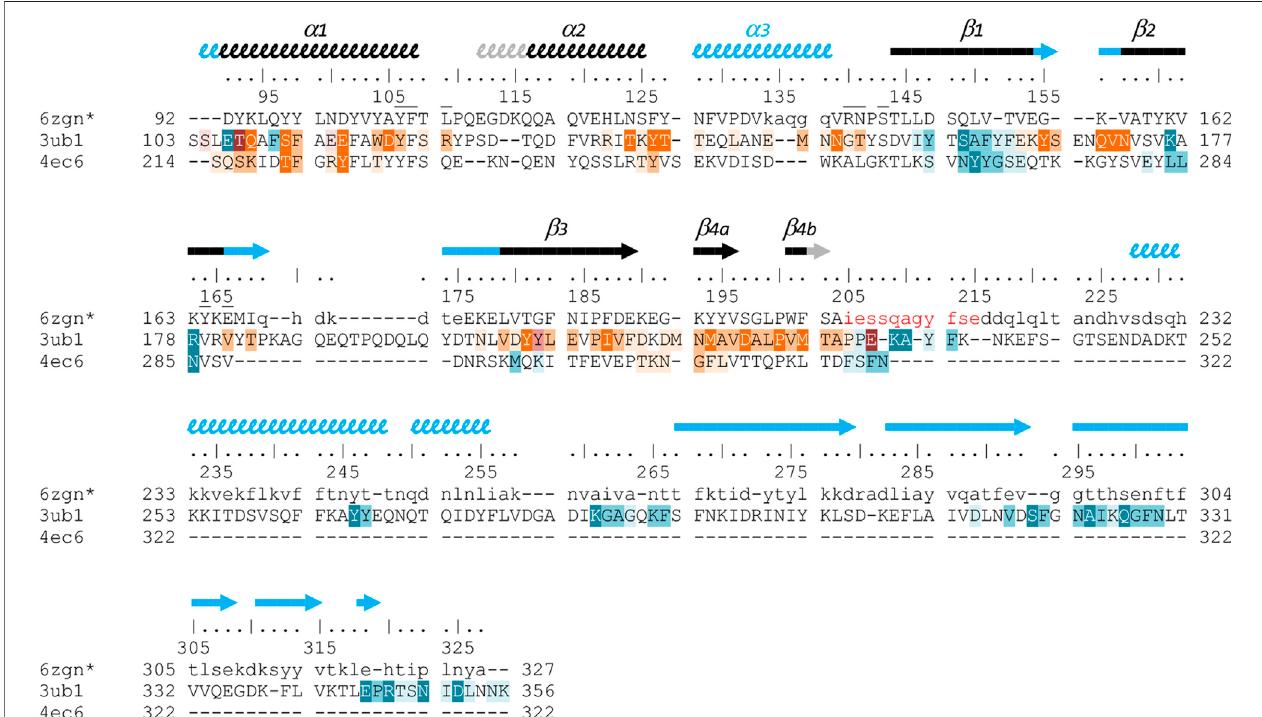
FIGURE 6 | Structure-based sequence alignment of three Gram-positive VirB8-like proteins. The sequence alignment was generated by mTM-align and manually modi fi ed, based onthethree structures ofOrfG 64 – 204 (pdb entry6zgn), TcpC 99 – 359 (3ub1) and TraM 190 – 322 (4ec6). Residues ofOrfG 64 – 204 thatwere notobserved inthe electrondensityareshownaslowercases,aswellasresidues205 – 327equivalenttotheC-terminaldomainofTcpCandforwhichnostructureisknownyet.Numbering above the sequences corresponds to OrfG. Secondary structures are represented by arrows ( β -strands) and squiggles ( α -helices), in black when shared by OrfG and TcpC, in grey when only present in OrfG, and in cyan when only present in TcpC. Residues of TraM and TcpC involved in the trimer assemblies are highlighted, in orange in one partner and in blue in the facing monomer: white letters with dark background are for residues involved in hydrogen bonds in all interface instances in the asymmetric units, while dark letters with lighter background are involved in contact in at least one interface (medium background when at least 50% of the residue is buried in the contact, light background if less than 50% is buried). Residues of OrfG 64 – 204 that delineate the pocket in which an unknown ligand is bound (see Supplementary Figure S1 ) are marked with an